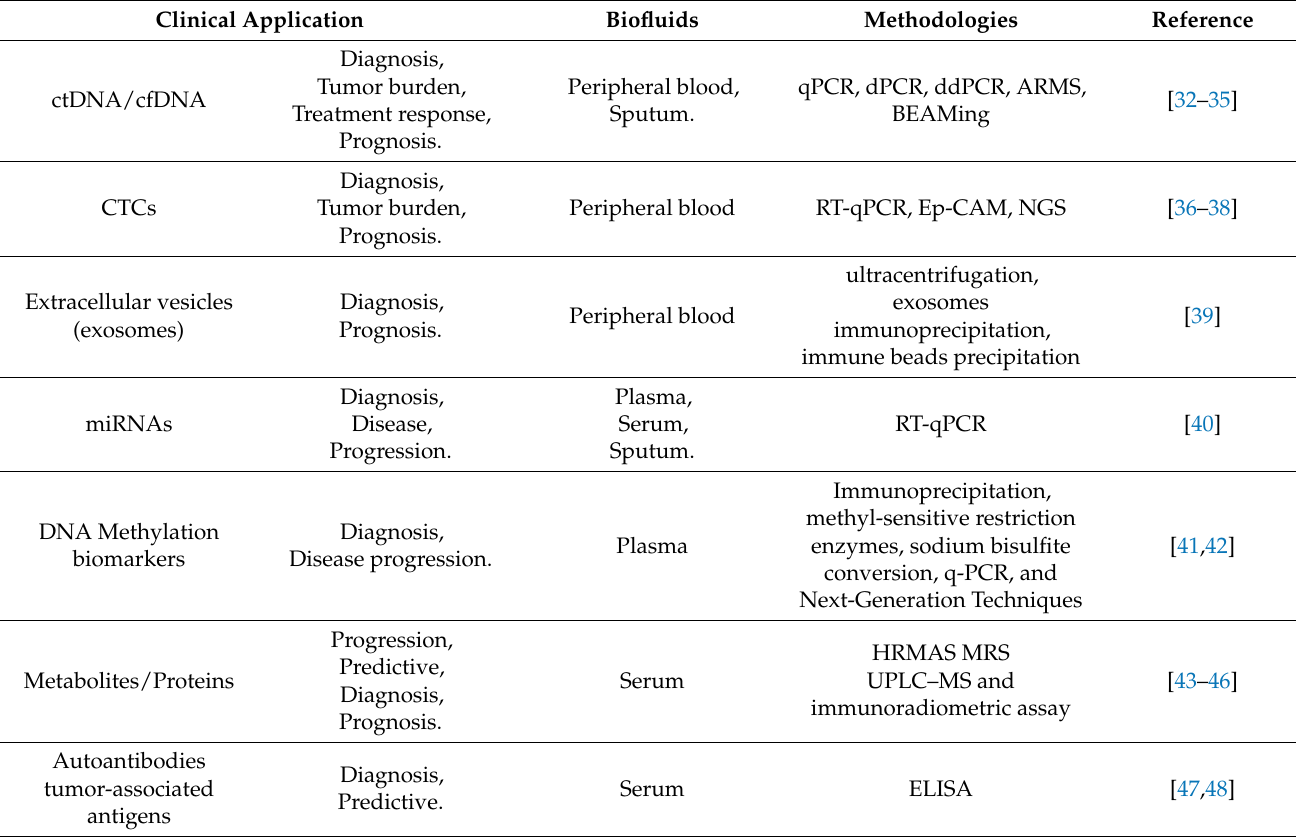
Table 1. Liquid biopsy analytes for NSCLC: major clinical applications, biofluids, and methods.